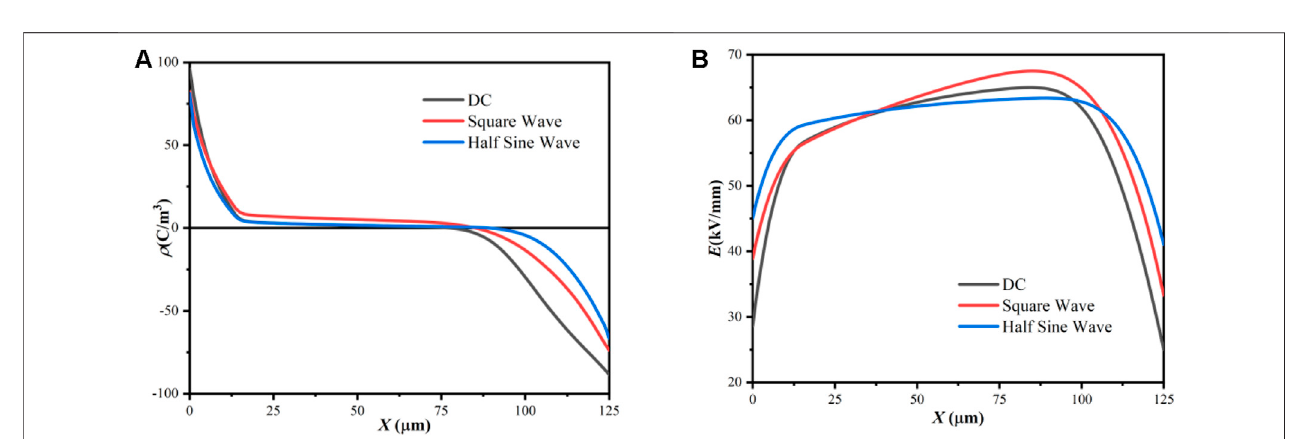
FIGURE 8 | Simulation results under voltages with different waveforms: (A) space charge distribution, (B) electric fi eld distribution.